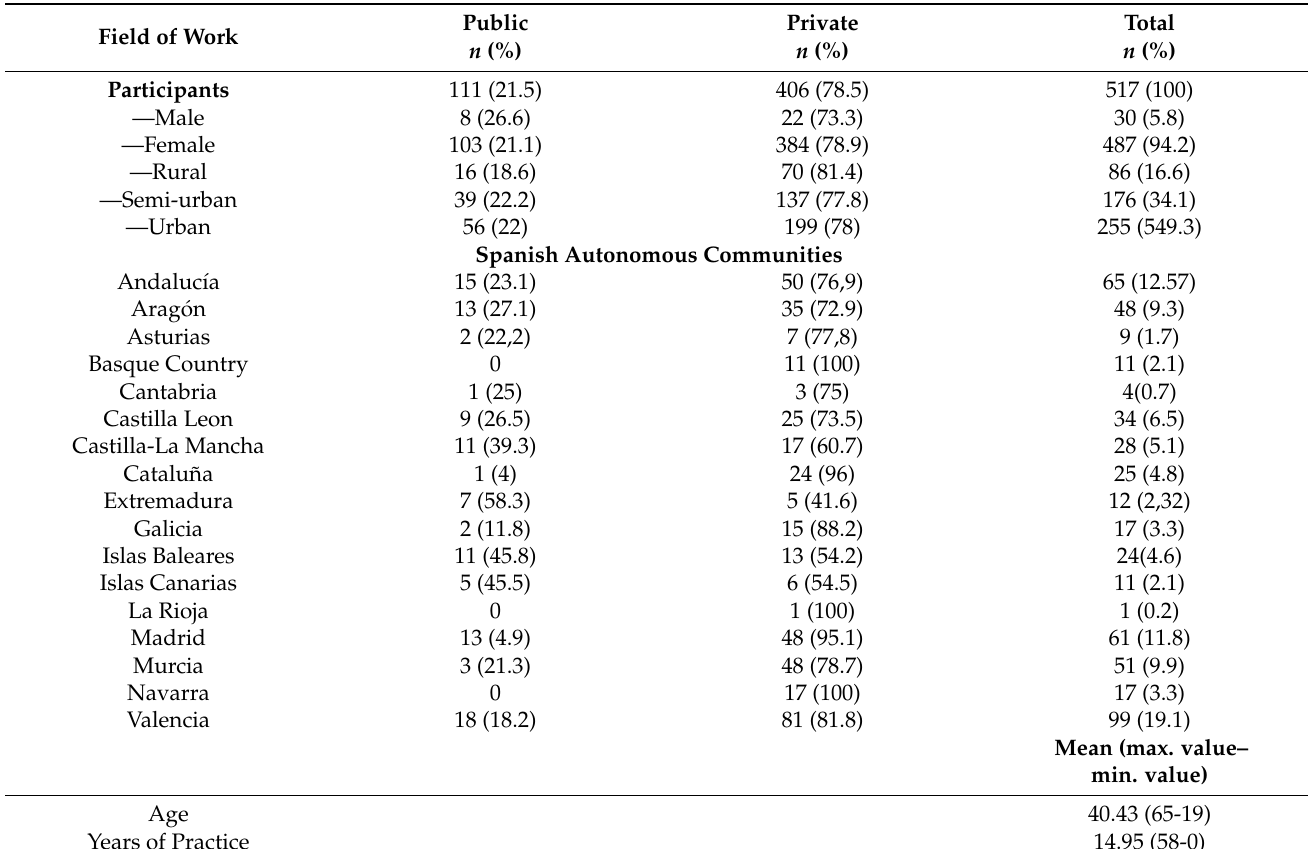
Table 2. Geographical distribution and sociodemographic characteristics of the sample regarding field of work. Field of Work